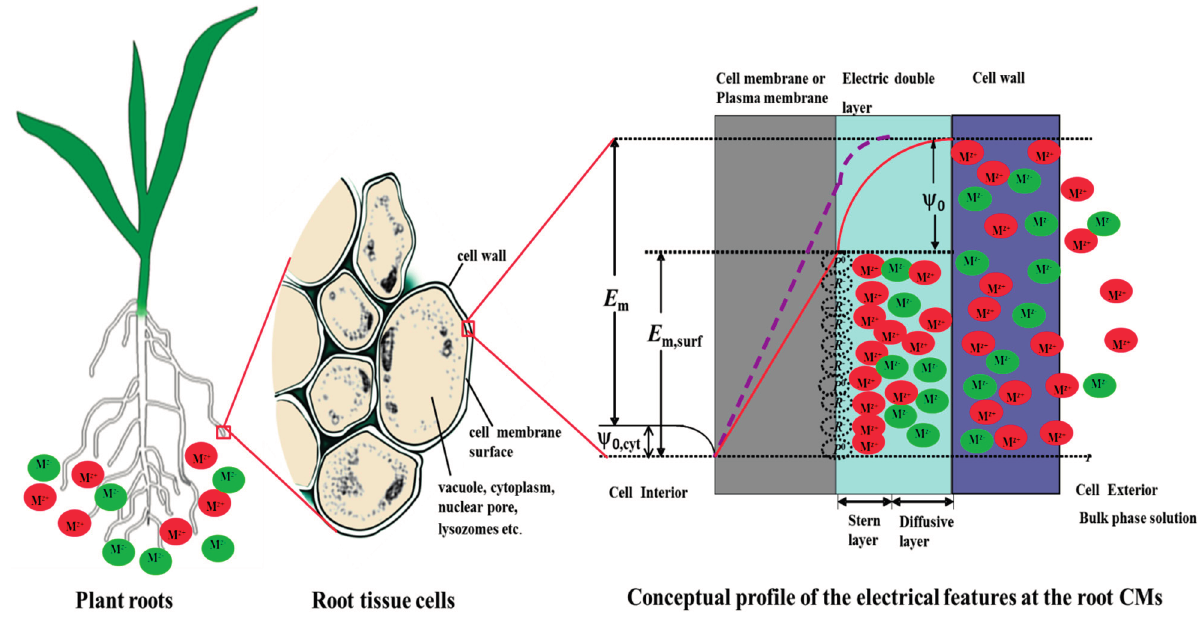
Figure 1. Schematic diagram of electrical profiles and ion distributions at a plant root cell surface, as described in the text. Cations are denoted by M z + (in red circle), and anions are denoted by M z − (in green circle). − R − and − P 0 denote negatively charged and uncharged membrane components exposed at the outer surface of the plasma membrane (PM). The solid curve represents the profile of electrical potential from the external medium to the inner surface of the PM; The dashed curve illustrates this profile after the addition of surface-depolarizing solutes to the external medium. E m is the transmembrane electrical potential difference from the bulk solution to the cell interior; ψ 0 is the potential difference between the PM outer surface and the external medium; E m,surf is the potential difference from the plasma membrane exterior surface to the membrane interior; and ψ 0,cyt is the potential difference between the PM inner surface and the cell cytoplasm. ψ 0 and E m,surf are altered, but ψ 0,cyt and E m remain